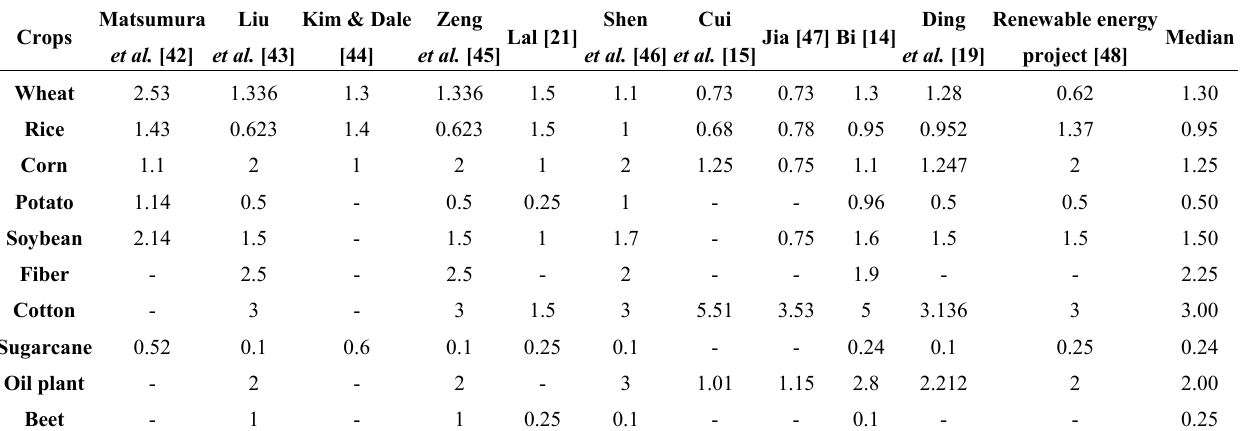
Table 1. Residue-to-production ratio for various crops.